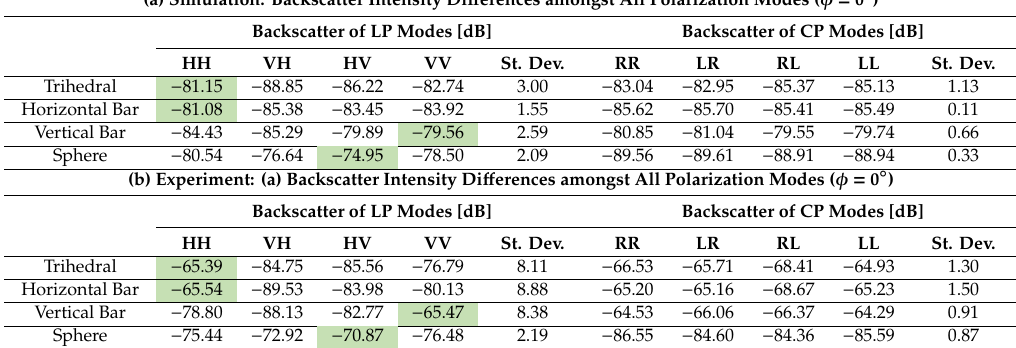
Table 5. Backscatter intensity di ff erences amongst LP modes compared to CP modes: ( a ) Simulation and ( b ) experiment. Please notice that the backscatter intensities of CP modes varied less significantly compared to LP modes. The ones shaded in green are the largest values of each target for the LP modes. (a) Simulation: Backscatter Intensity Di ff erences amongst All Polarization Modes ( φ = 0 ◦